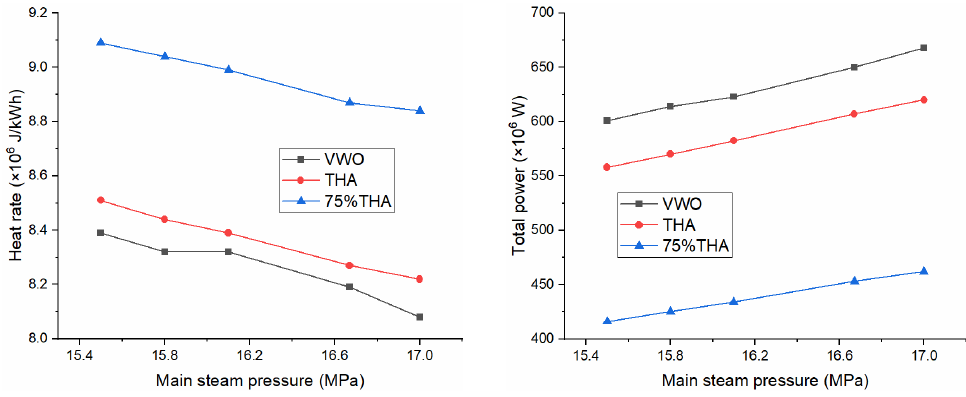
Figure 8. Main steam pressure vs. heat rate; main steam pressure vs. power.